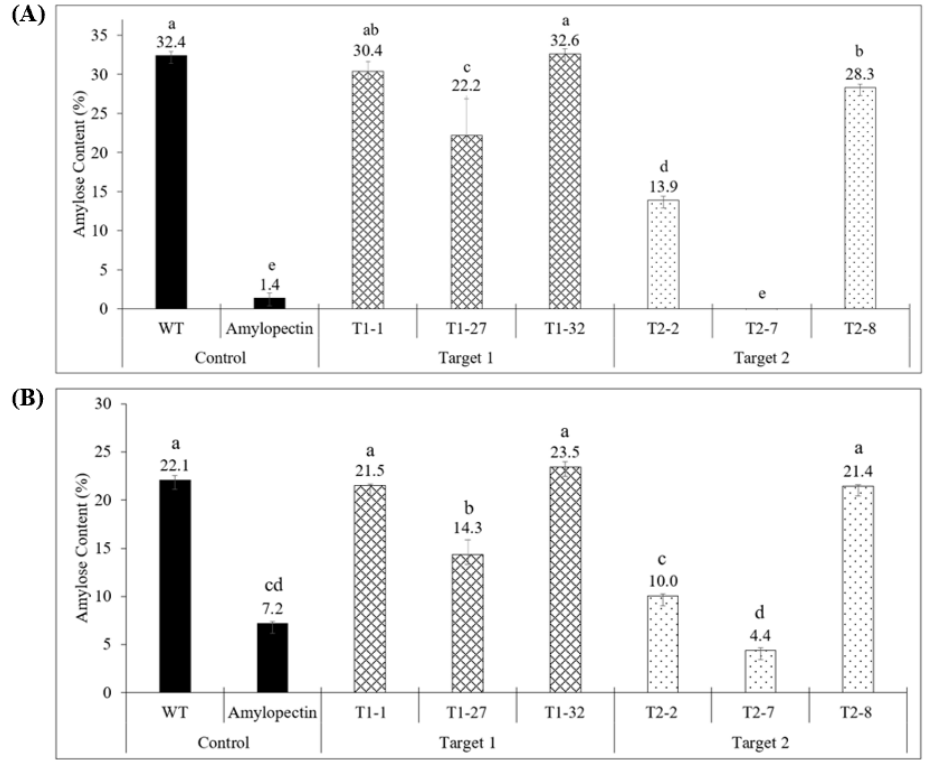
Figure 5. Amylose values in wild ‐ type (WT, Yukon Gold strain TXYG79) and six different knock ‐ out events. ( A ) Colorimetric determination of amylose content using the perchloric acid method. ( B ) Colorimetric determination of amylose content using the commercial amylose/amylopectin Megazyme kit. A 100% amylopectin solution was also used as a control. Data represent mean ± SE; n = 4–6; different lower ‐ case letters over bars indicate significant difference between plant types; p ≤ 0.05 (Student’s t ‐ test).